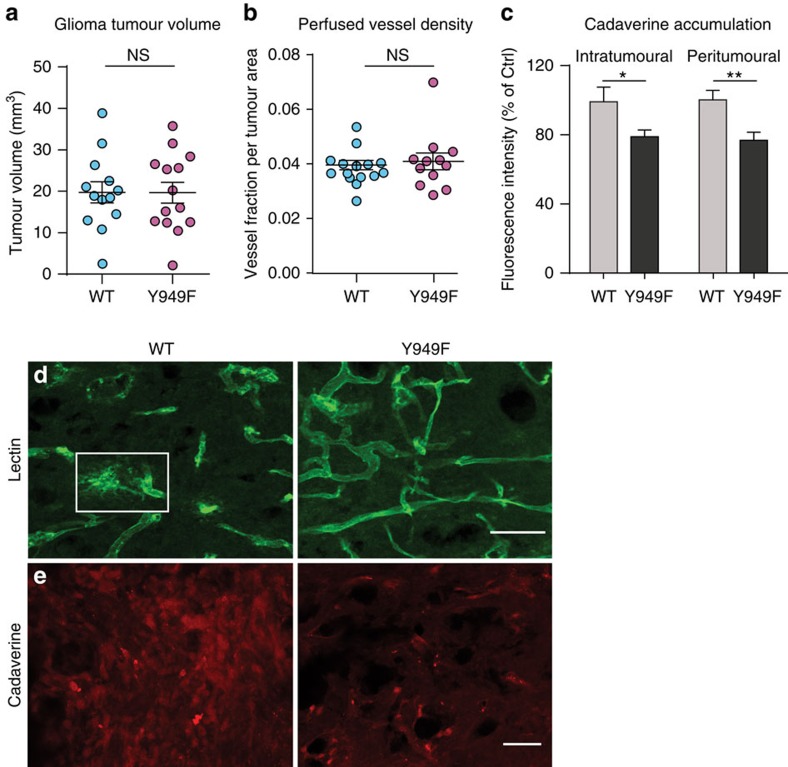
Reduced glioblastoma permeability in Vegfr2Y949F/Y949F mice.(a) GL261 glioma volumes at D18, estimated by measuring all tumour-containing sections in series throughout the brain of WT and Vegfr2Y949F/Y949F (Y949F) mice. n=13–14 mice per genotype. (b) Lectin-positive, perfused vessel density (area fraction per tumour area) at D18. n=12–14 mice per genotype. (c) Cadaverine-555 fluorescence intensity units estimated within the tumour (intratumoural) and at a 0–500-μm rim around the tumour border (peritumoural), Y949F normalized to WT. n=8–11 mice per genotype. (d) GL261 lectin-perfused vessels (lectin in green). Boxed area, typical point of leakage/disrupted barrier in the WT. (e) Cadaverine-555 (red) extravasation in WT and Y949F GL261 gliomas. Scale bar, 100 μm (d) and 50 μm (e). Data are presented as mean±s.e.m. Student's t-test, *P<0.05, **P<0.01. Experiments were performed three independent times. NS, not significant.